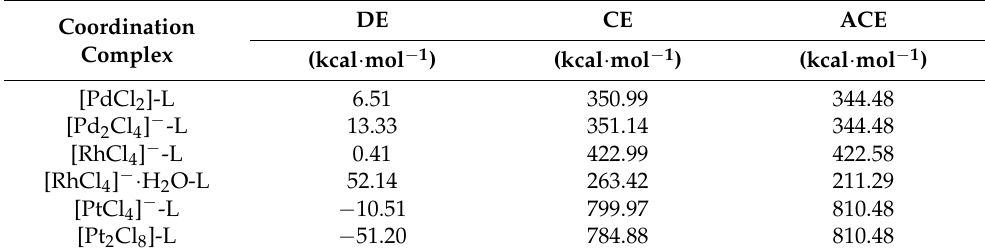
Figure 10. The optimized structure of two typical coordination complexes (at B3LYP/def2-QZVP level). Table 7. The energy change (DE) in some coordination reactions of L with [MClx]z − and coordination strength (CE) of L with metal chloride anion (at B3LYP/def2-QZVP